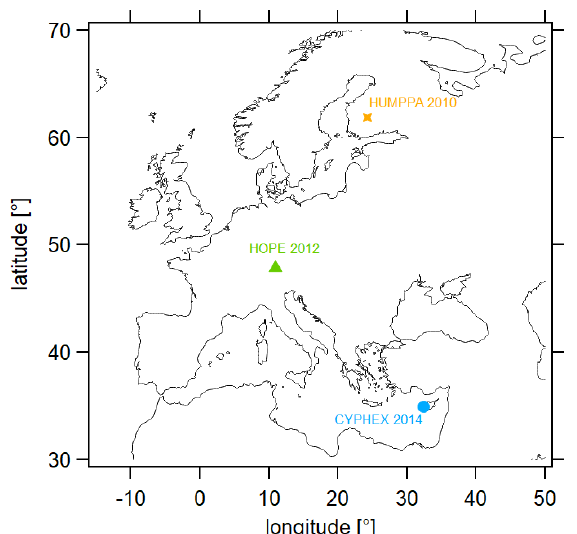
Figure 3. Geographic locations of the measurement sites included in this analysis. CYPHEX – 34.96 ◦ N, 32.38 ◦ E, 650ma . s . l . (above sea level) and UTC + 128min (mean local time); HOPE – 47.80 ◦ N, 11.01 ◦ E, 980ma . s . l . and UTC + 44min; HUMPPA – 61.85 ◦ N, 24.28 ◦ E, 181ma . s . l . and UTC +